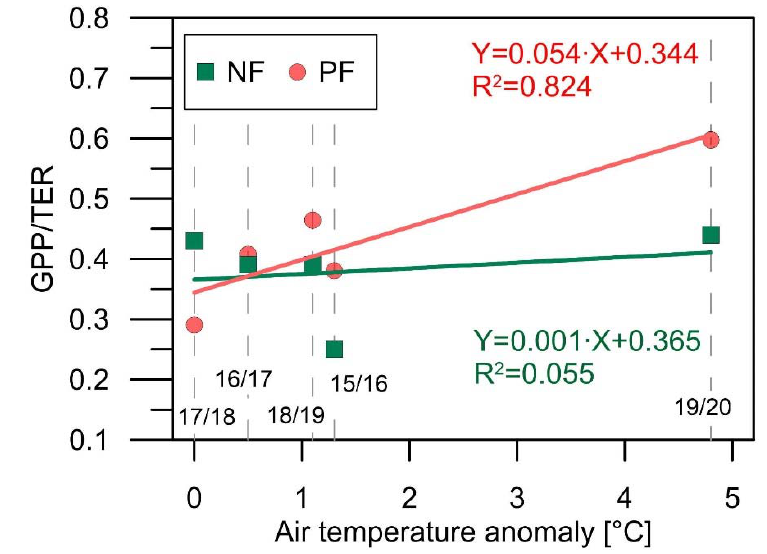
Figure 9. The relationship between the mean winter (1 November–31 March) GPP/TER ratio and the winter temperature anomaly in the nemorose spruce forest (NF, this study) and the paludified spruce forest (PF) [51] for the 2015–2020 period. Dash bars correspond the winters of the period (e.g., the label 15/16 means the winter 2015/2016).